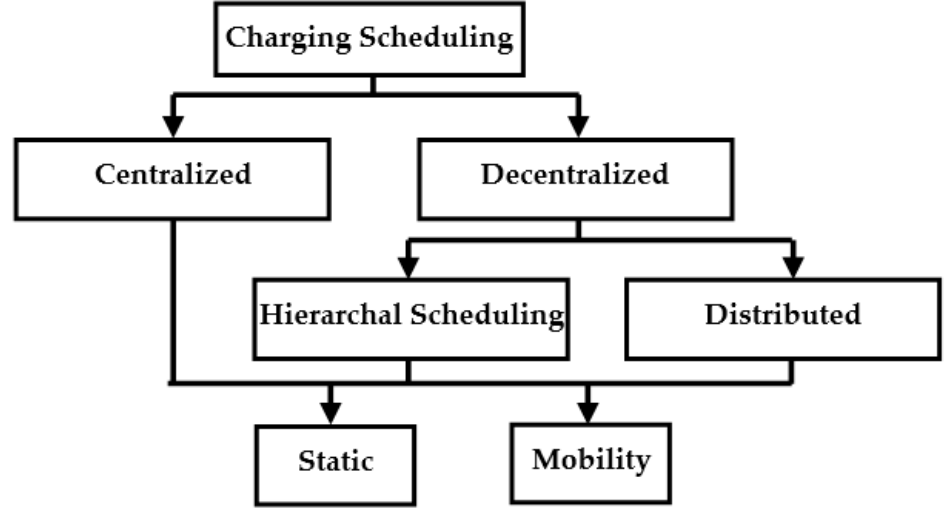
Figure 5. Classification of charge scheduling problem [103].